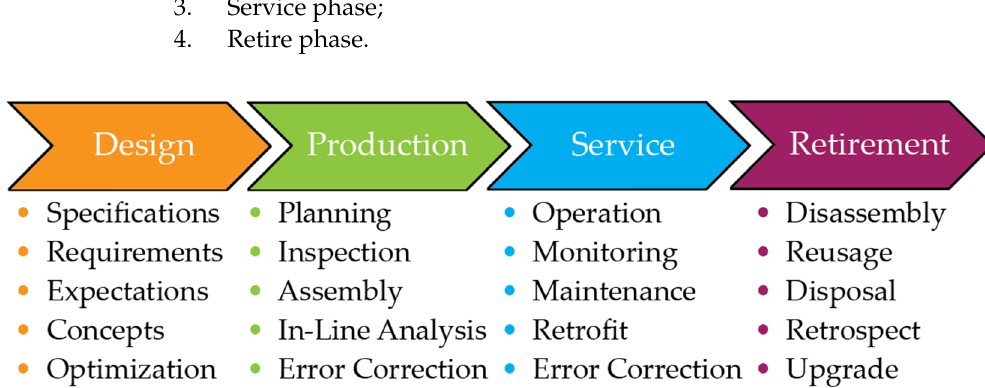
Figure 2. Summary of a product lifecycle and relevant operations.